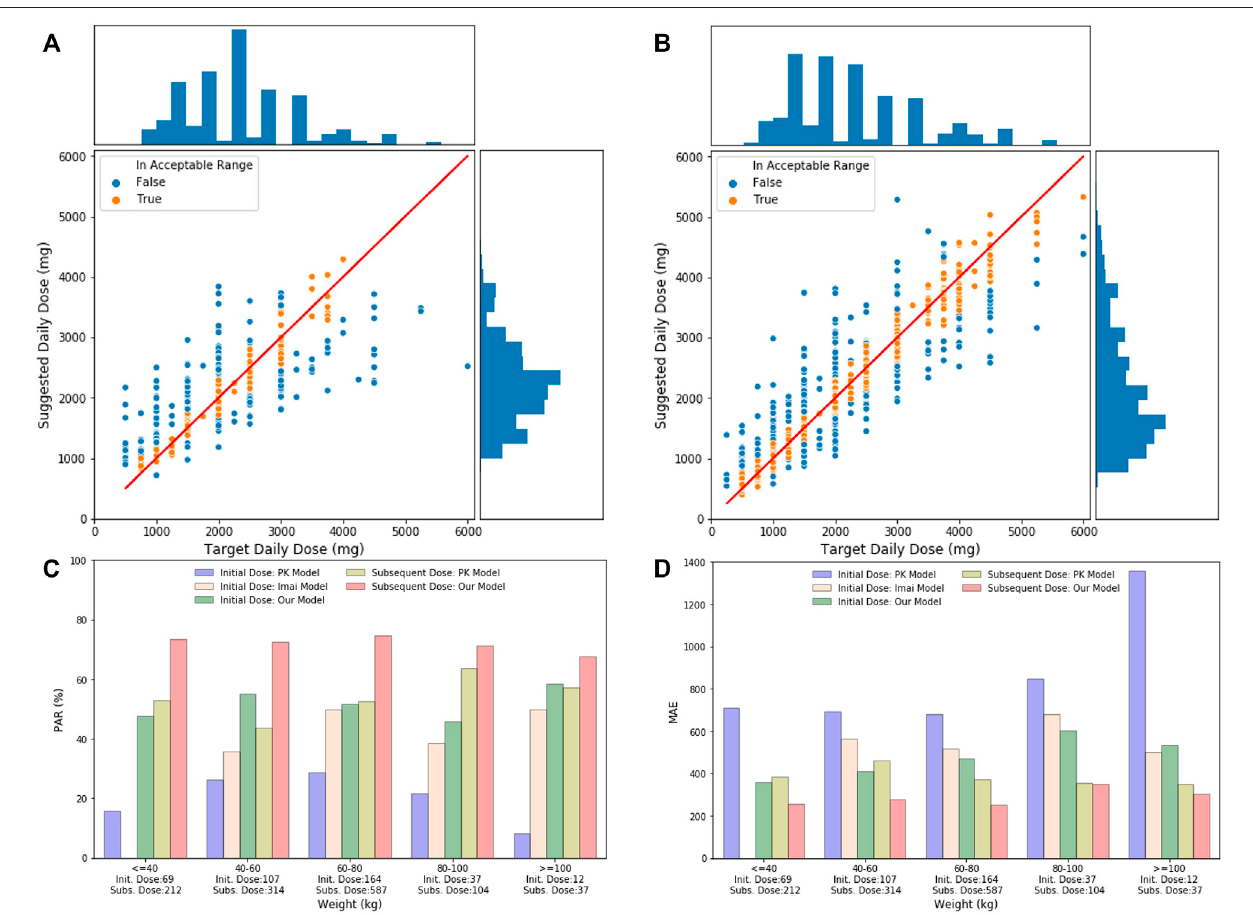
FIGURE 5 | (A) Initial daily dose suggested by our models and the target daily dose in the test set. The solid line indicates perfect match where the suggested daily dose equals to the target daily dose. The bar chart on the top is the distribution of target daily dose, and the bar chart on the right shows the distribution of suggested daily dose. (B) Subsequent daily dose suggested by our models and the target daily dose in the test set. (C) Comparison of PAR of different models, including the PK initial dose model, Imai model, our initial model, PK subsequent model, and our subsequent model, strati fi ed by patient ’ s weight groups in test data. Number of records in each weight group is shown under the x -axis. (D) Comparison of MAE of different models, including the PK initial dose model, Imai model, our initial model, PK subsequent model, and our subsequent model, strati fi ed by patient ’ s weight groups in test